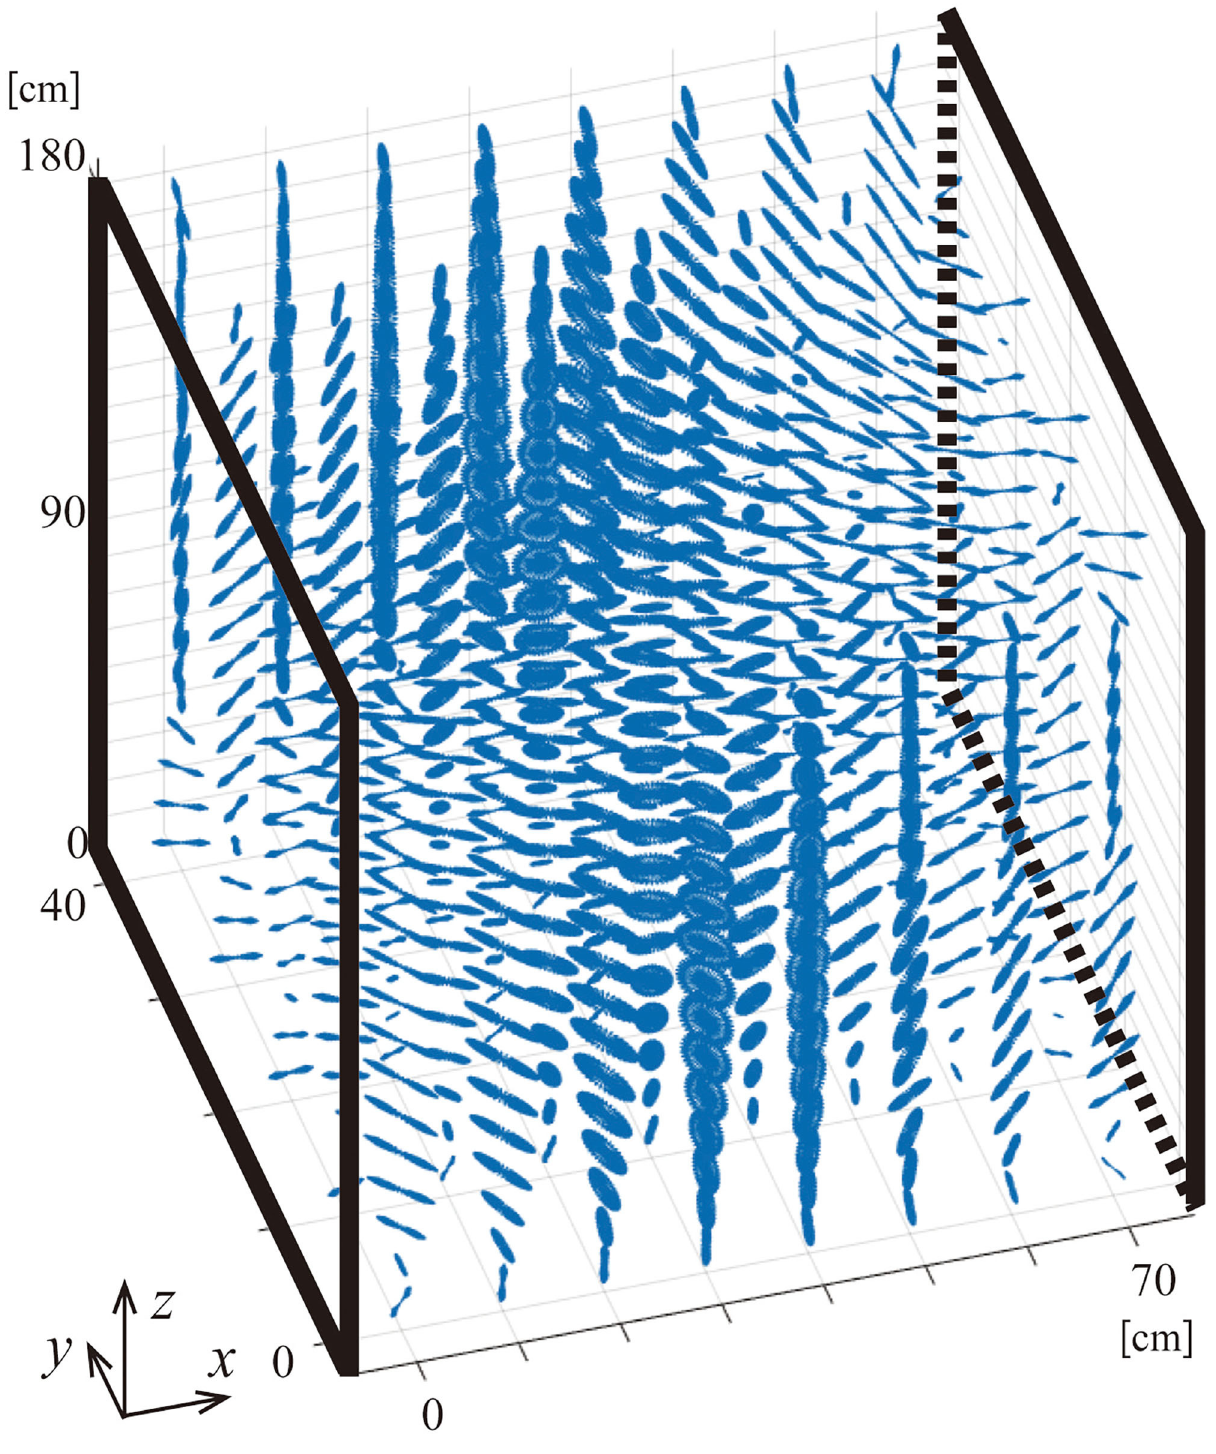
Frontiers in Public Health |